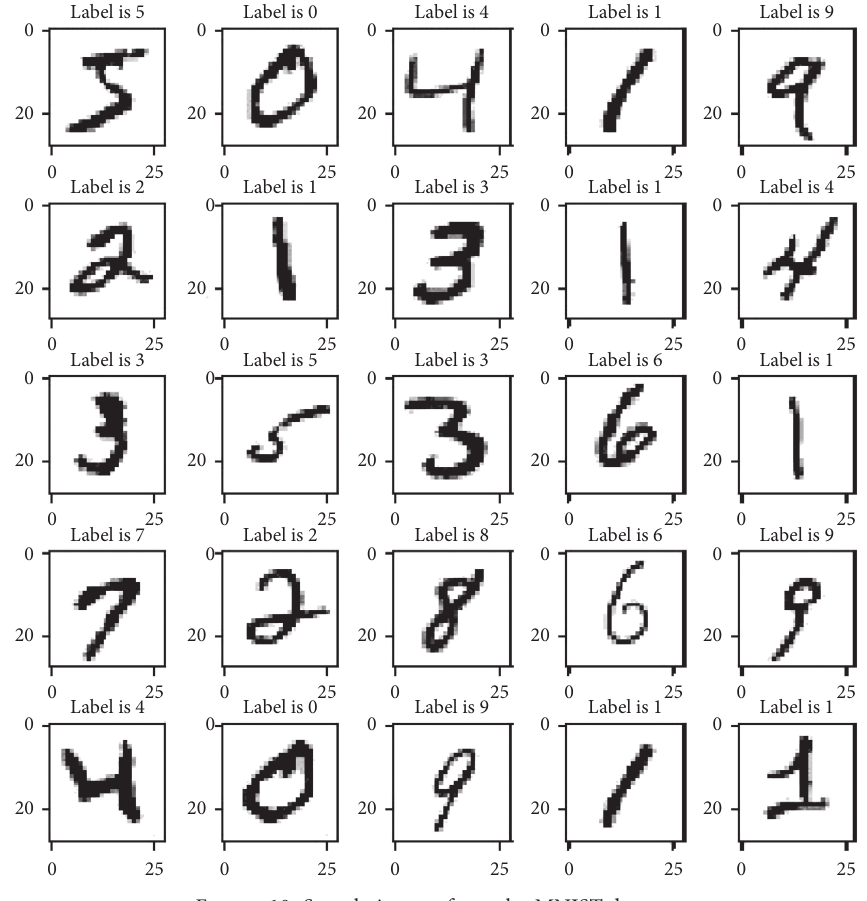
Figure 10: Sample images from the MNIST dataset.